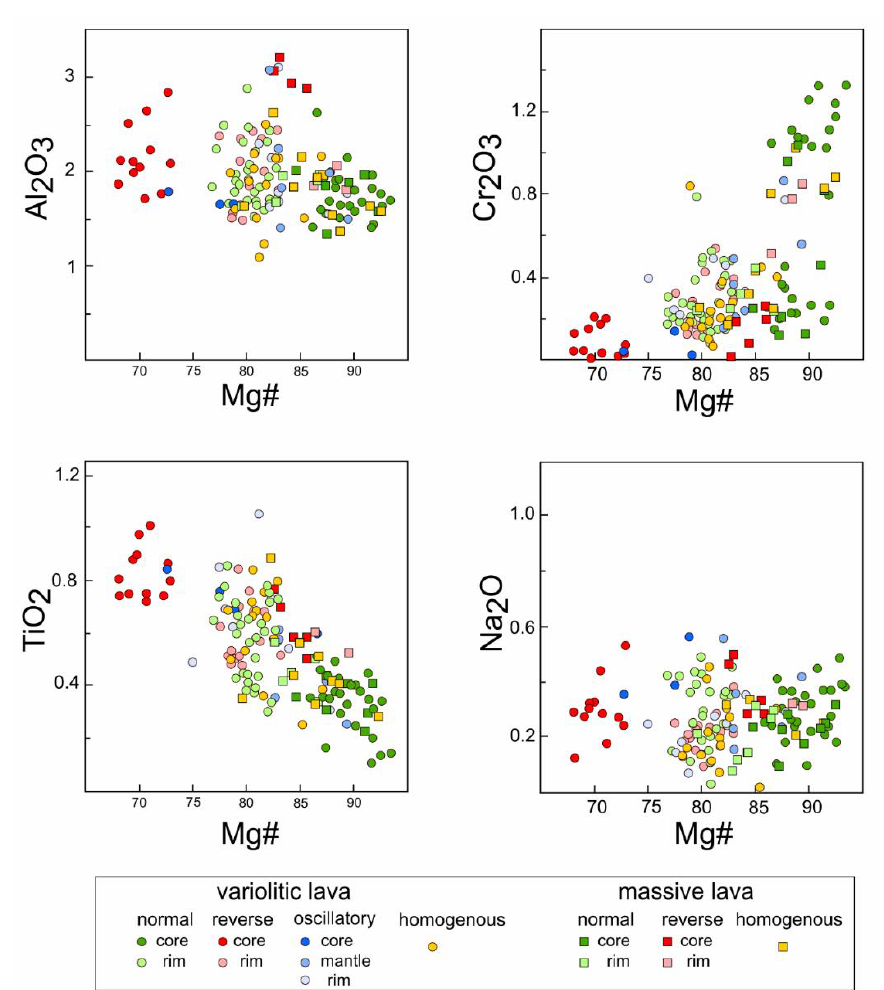
Figure 4. Compositional variations of clinopyroxene phenocrysts from the variolitic and massive lavas of the Yalguba Ridge in terms of Mg# vs. A 2 O 3 , Cr 2 O 3 , TiO 2 and Na 2 O (concentration in wt.%).